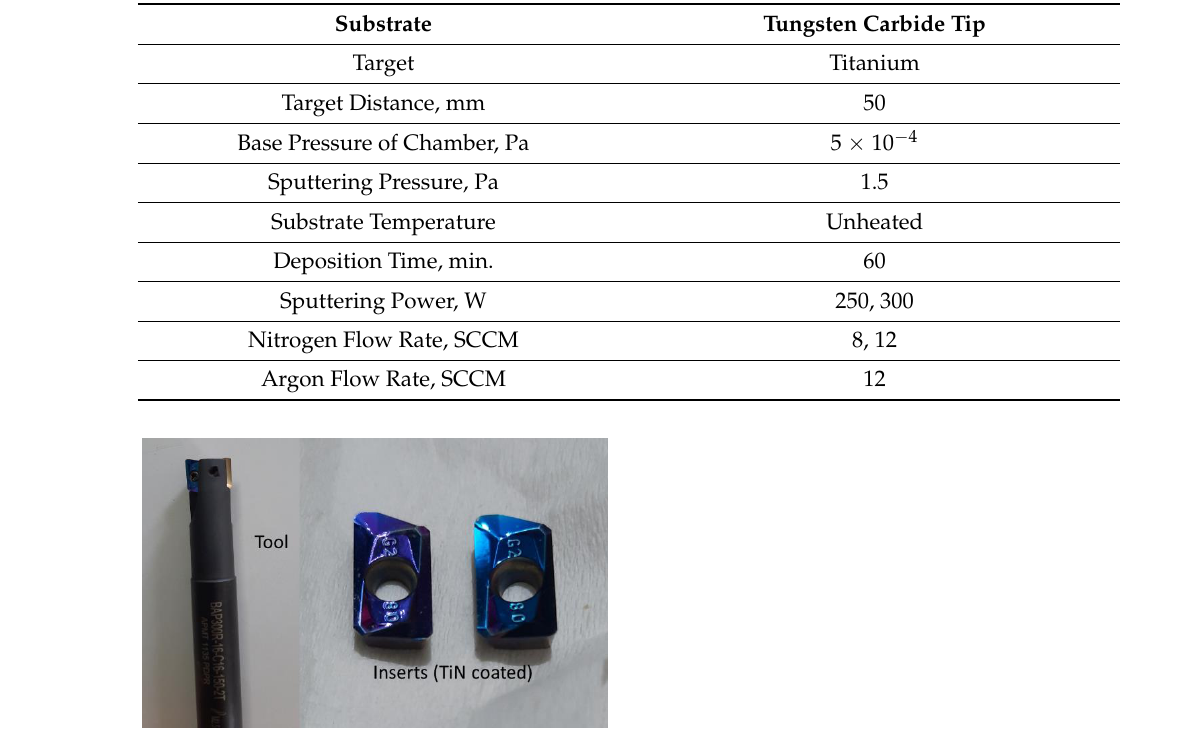
Figure 3. Cutting tool with TiN-coated inserts.